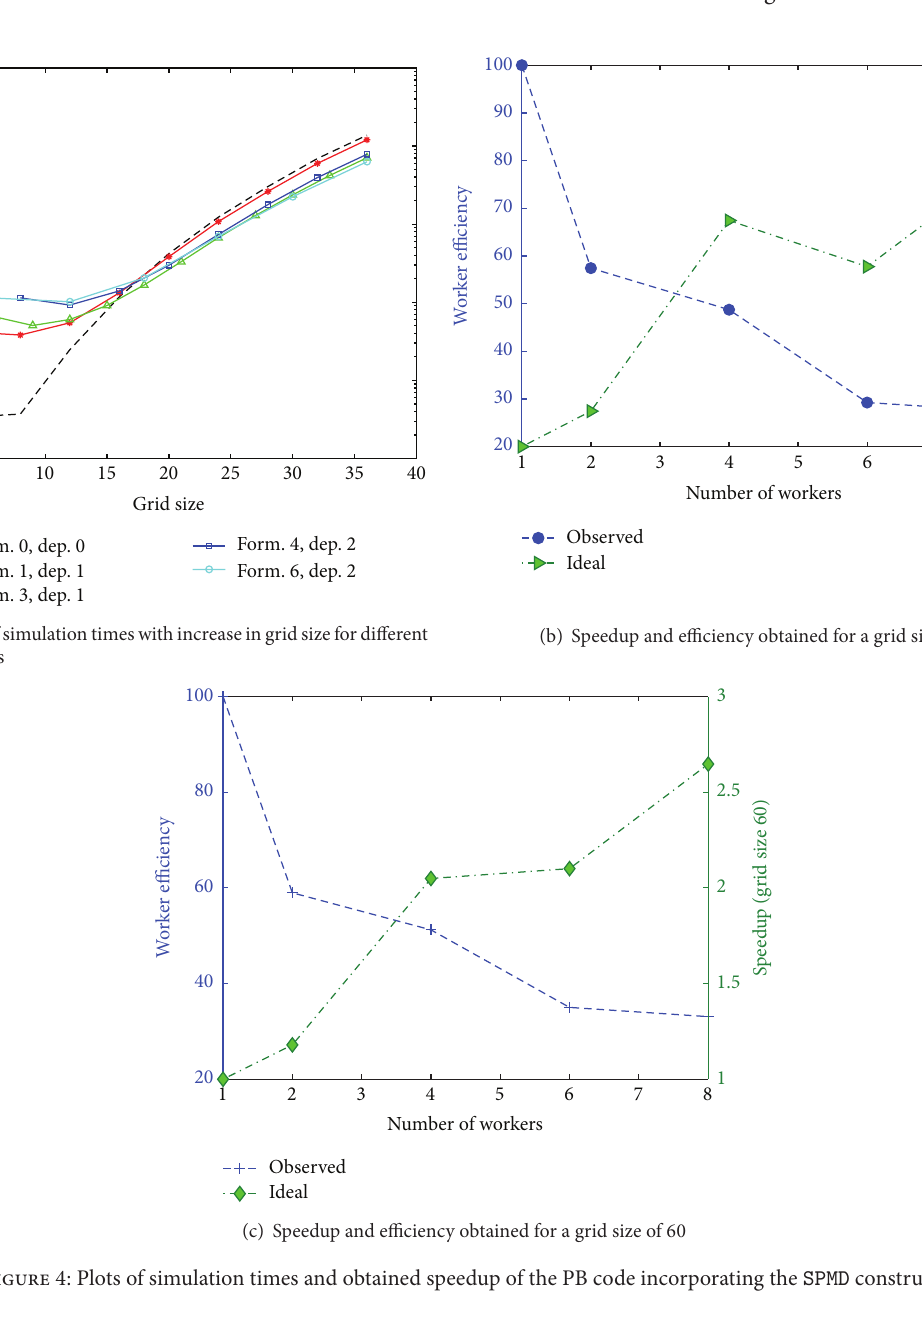
observed that the most efficient way of parallelization for 6 cores was by splitting formation 5 times and depletion 1